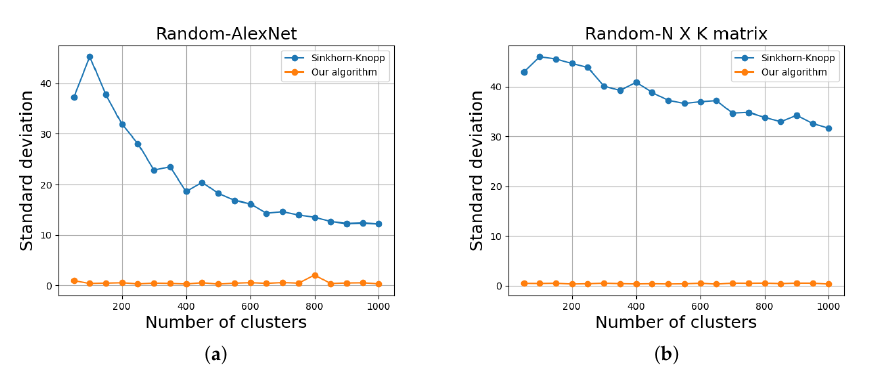
Figure 6. For N = 50,000, comparisons between the Sinkhorn–Knopp algorithm and our algorithm: we consider 20 different k (50,100,150, · · · ,1000) for two kinds of N × K matrices: one is output of the randomly initialized AlexNet with CIFAR-10; one is randomly created N × k matrix. In both ( a , b ), for all k , our algorithm has better performance on approaching even